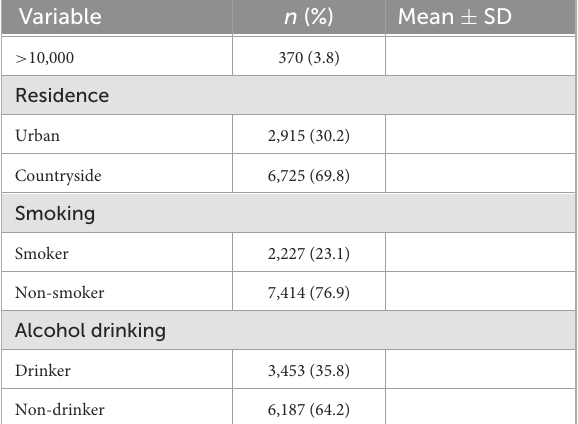
TABLE 1 Demographic characteristics of the middle-aged and elderly people ( n =